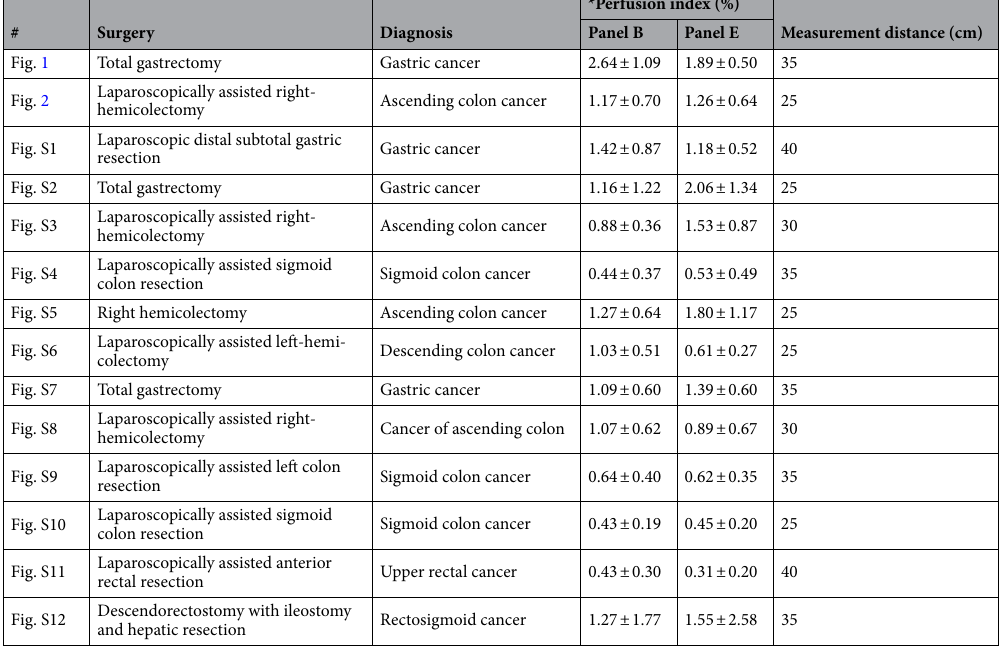
Laparoscopically assisted left colon resection Laparoscopically assisted sigmoid colon resection Laparoscopically assisted anterior rectal resection Fig. S12 Descendorectostomy with ileostomy and hepatic resection Rectosigmoid Table 1. Surgical cases monitored by the iPPG system. *Perfusion index is expressed as mean ± standard deviation.